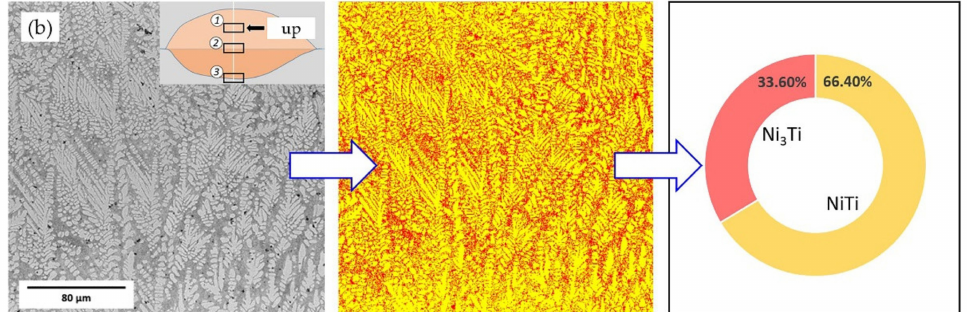
Figure 11. Phase proportion calculation result of the coating upper area via Image-Pro Plus 6.0: ( a ) 55 NiTi cladding layer; ( b ) 55 NiTi + 5 Ni cladding layer.